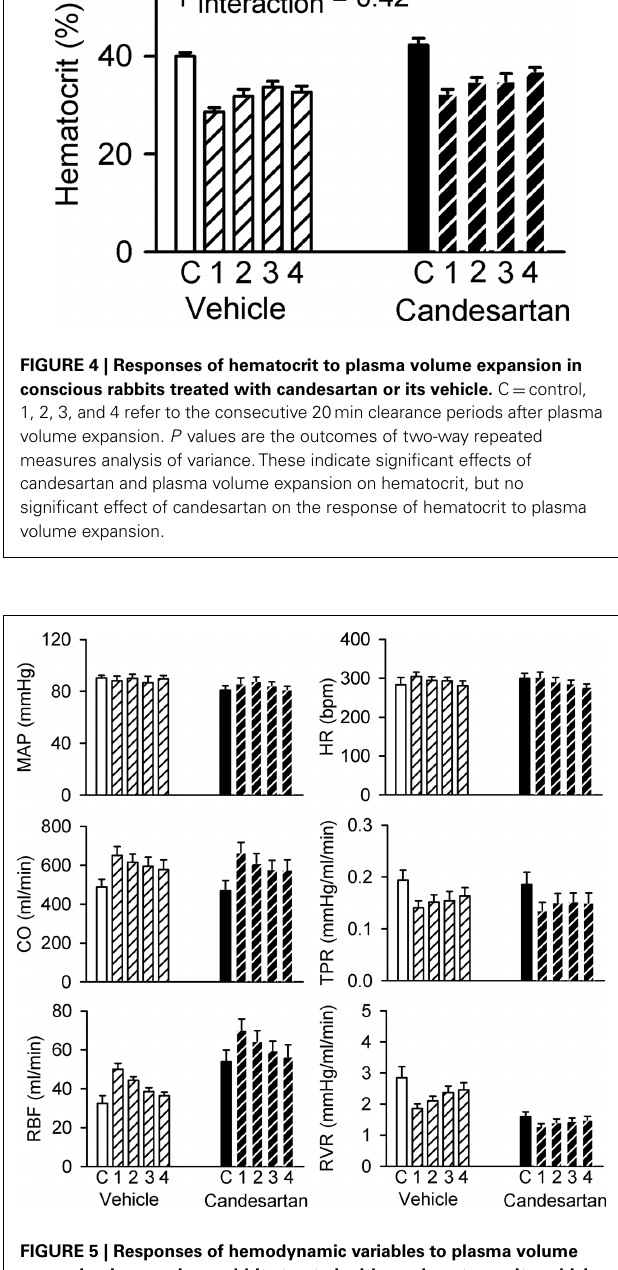
FIGURE 5 | Responses of hemodynamic variables to plasma volume expansion in conscious rabbits treated with candesartan or its vehicle. MAP, mean arterial pressure; HR, heart rate; CO, cardiac output; RBF, renal blood flow;TPR, total peripheral resistance; RVR, renal vascular resistance. C = control, 1, 2, 3, and 4 refer to the consecutive 20min clearance periods after plasma volume expansion. P values for the outcomes of two-way repeated measures analysis of variance are shown in Table 2 .These indicate significant effects of candesartan on RBF and RVR and significant changes in CO, RBF,TPR, and RVR in response to plasma volume expansion. However, there were no significant effects of candesartan on the responses of these variables to plasma volume